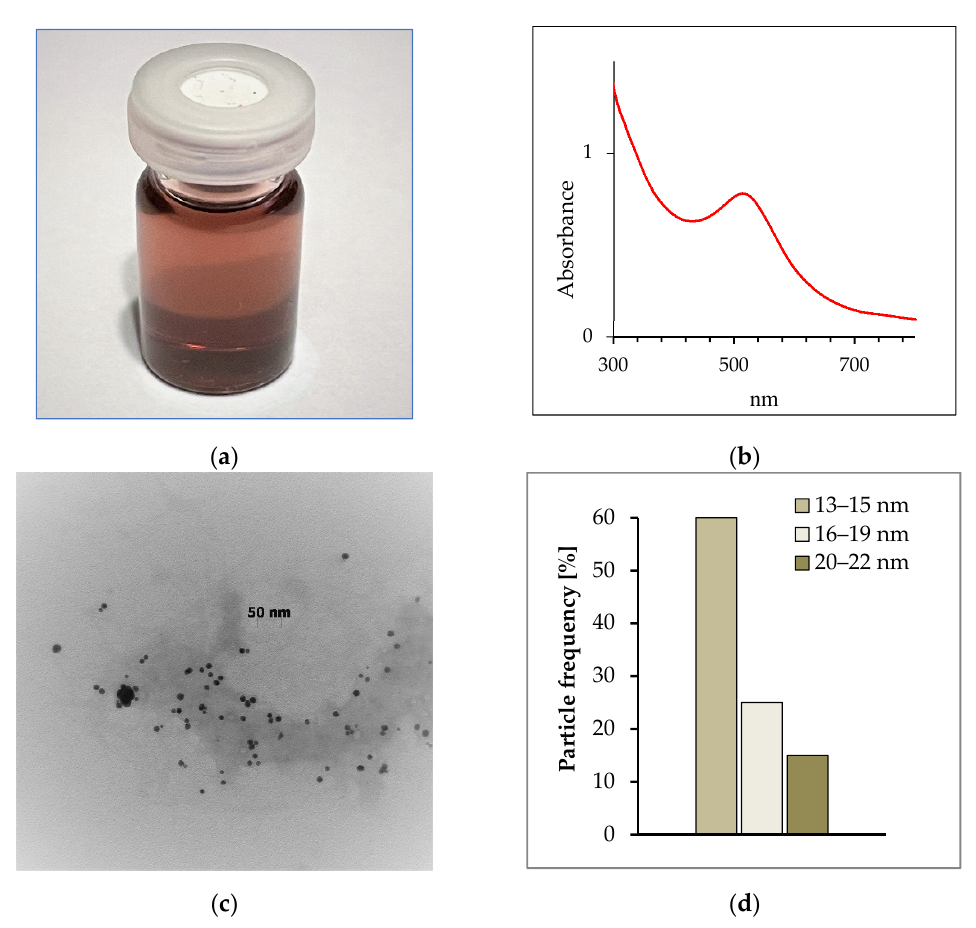
Figure 1. The color of the cell-free filtrate of Coriolus versicolor turning red after incubation with the gold ions: ( a ) absorption spectrum of the biogenic gold nanoparticles; ( b ) TEM image of the gold nanoparticles synthesized by the cell-free filtrate; ( c ) histogram of the size distribution of the gold nanoparticles ( d ).